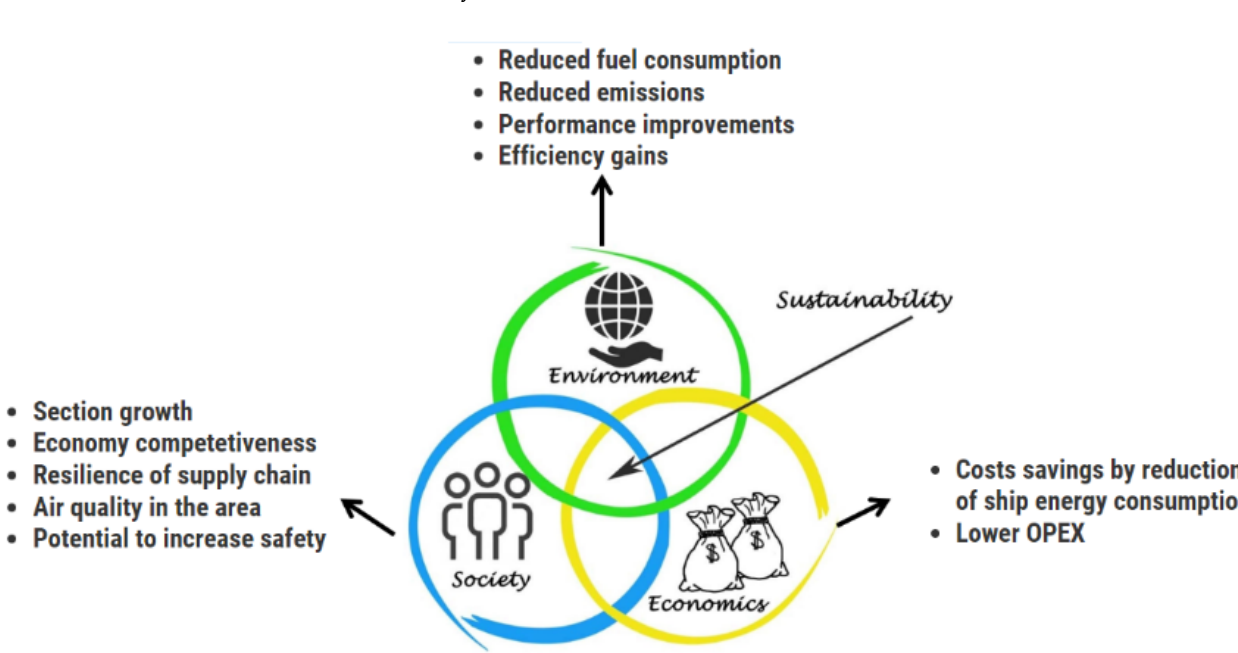
Figure 1. Sustainability of autonomous shipping.